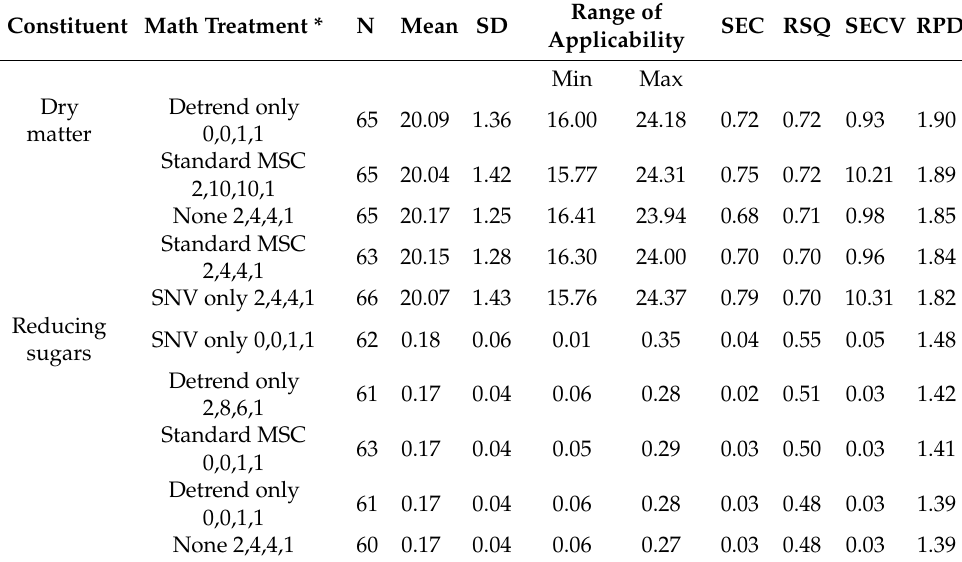
Table 2. Calibration descriptors of the best models obtained for each parameter by NIR. Constituent Math Treatment